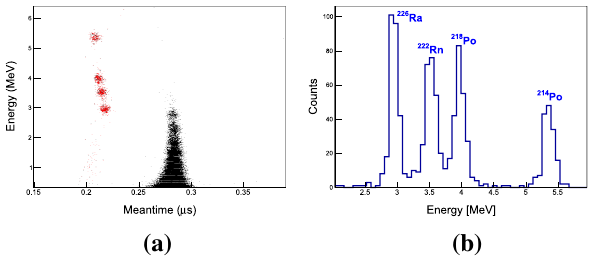
Fig. 7 The 40 K 3.2 keV spectra in the NaI(Tl) crystals tagged by a 1460 keV γ in the surrounding CsI(Tl) crystals. a A distinct 3.2 keV X-ray peak in NaI-025 reflects its high contamination of K. We model the energy spectrum (solid line) assuming a Gaussian 40 K signal (red-